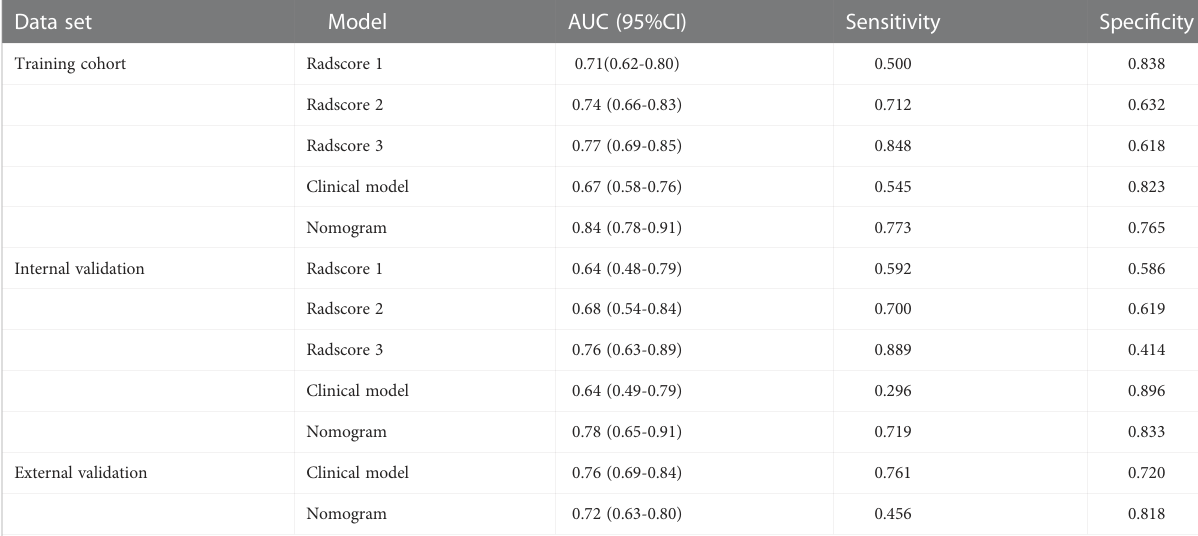
TABLE 3 Diagnostic performance of the radiomics model, clinical model, and the clinical-radiomic